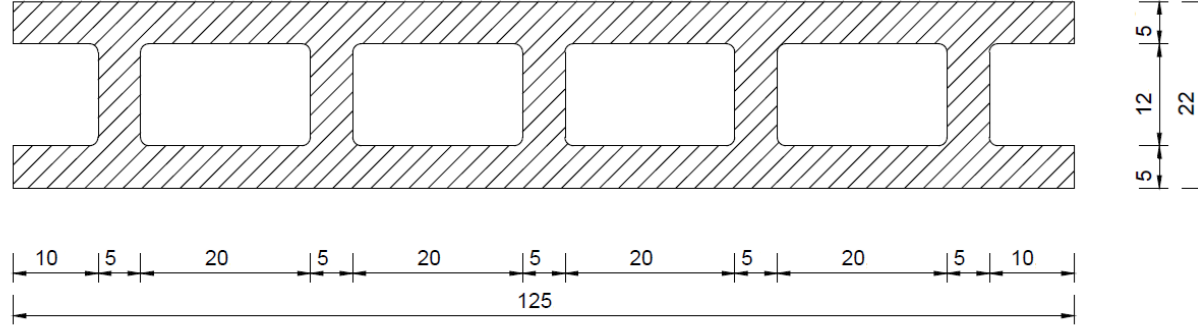
Figure 1. Shape of the profiles used in the tests. Samples with a width less than 20 mm were cut from the usable surface of the profiles, from the central part of the cells, between the vertical ribs parallel to the cells. Samples with a width of more than 20 mm were cut from the same surfaces after removing the ribs. Figure 2 shows the research flowchart with some photos of the experimental